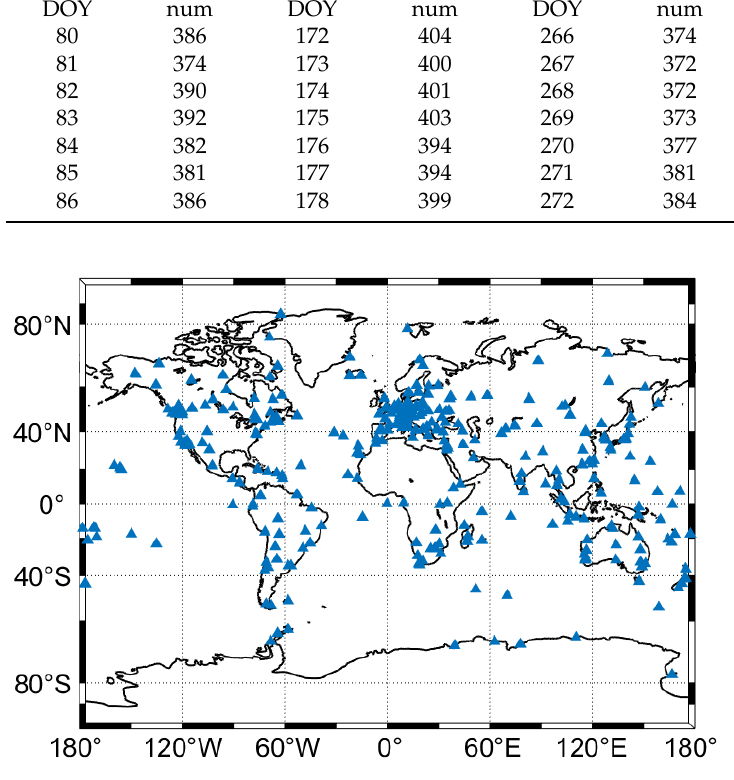
Figure 1. Distribution of global International GNSS Service (IGS) GPS sites.